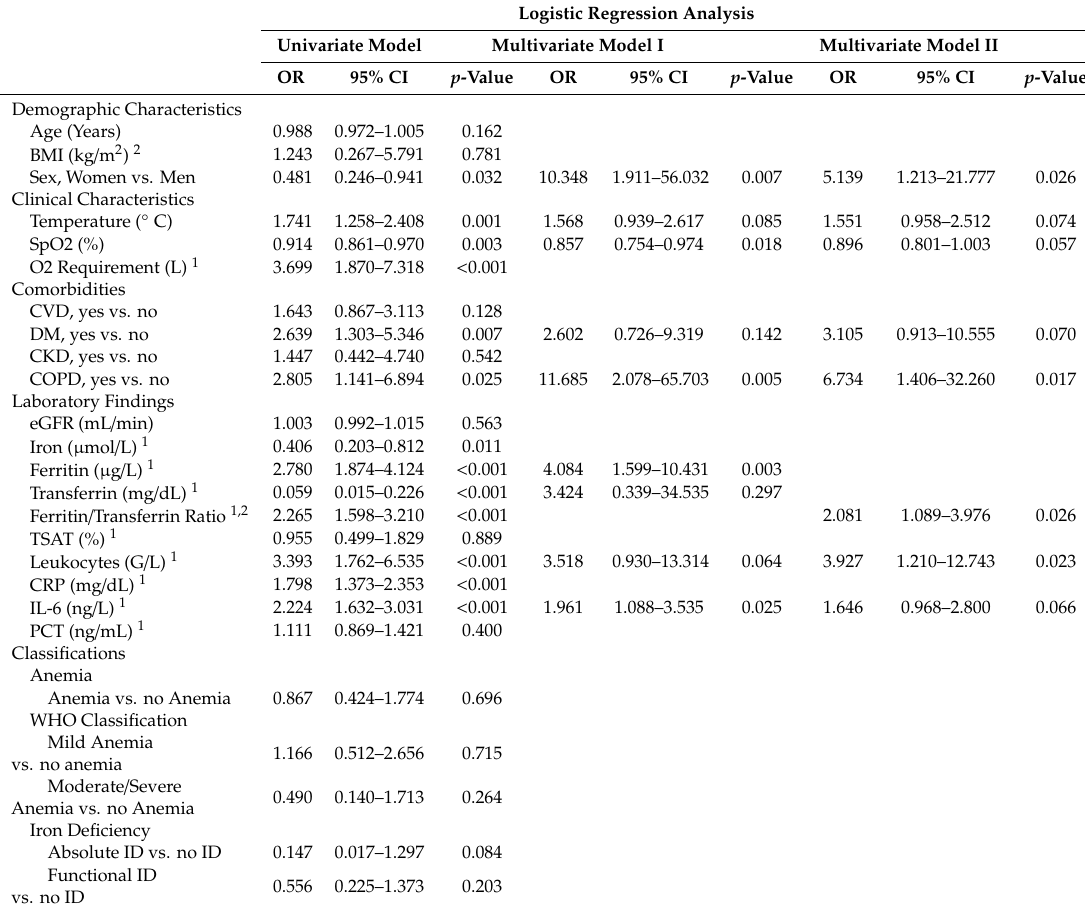
Table 3. Logistic Regression Analysis in terms of risk for ICU admission (yes / no).